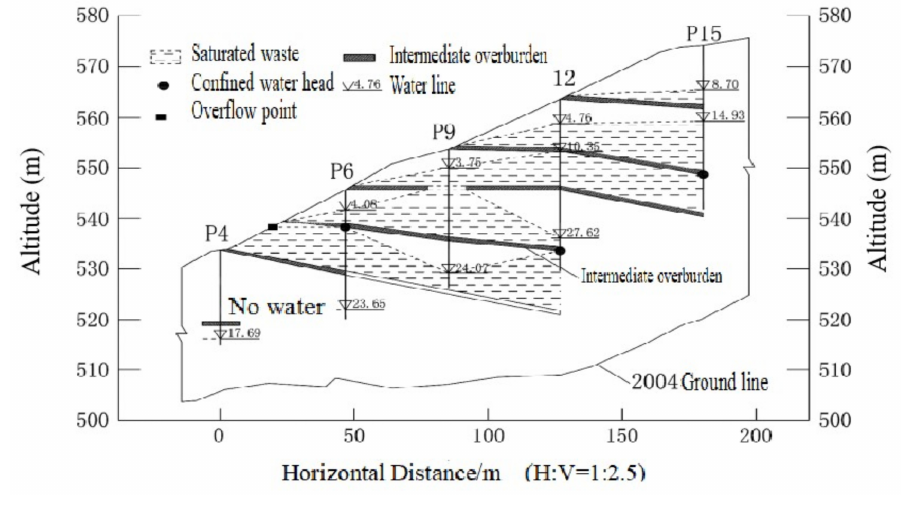
Figure 1. Multi-layer perched leachate in one landfill in China.